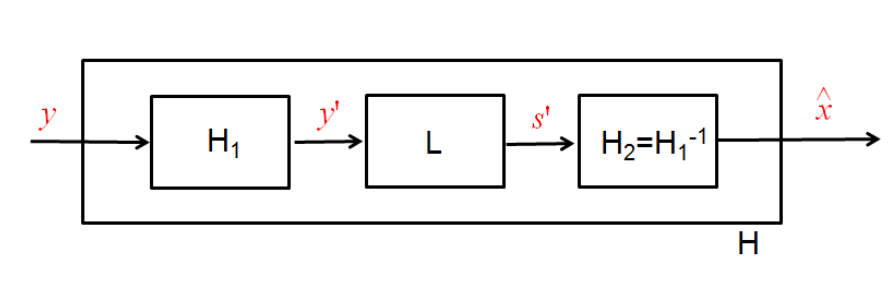
Figure 1. Methodology